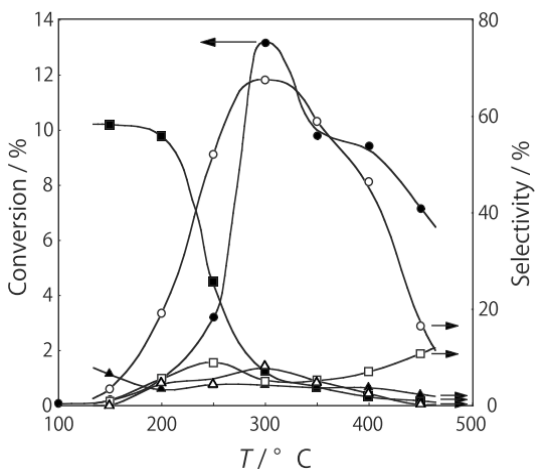
Figure 18. Effect of temperature on the methylation of phenol with methanol over (H O) [(Mo Cl )Cl ]·6H O/SiO . Following the activation of the supported cluster 3 2 6 8 6 2 2 (200 mg, 8.2 μmol) in a hydrogen stream (300 mL/h) for 1 h, reaction was initiated by introduction of phenol (17.8 μL/h, 0.20 mmol/h) and methanol (82.2 μL/h, 2.0 mmol/h) to the stream without changing the temperature. Conversion and selectivities are based on phenol. Conversion of phenol (●); selectivity for o -cresol (○); selectivity for m - and p -cresols (□); selectivity for anisole (■); selectivity for dimethylphenols (∆); and selectivity for ethylphenols (▲); at 3 h after the start of the reaction. Decomposition products are omitted for